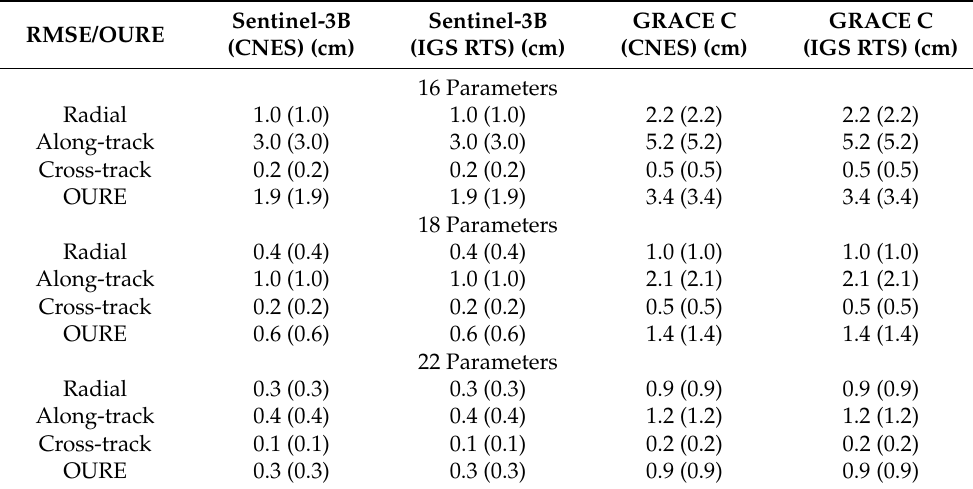
Table 10. Averaged RMS and OURE of the ephemeris fitting errors for the predicted orbits of 5–15 min. The results without outlier exclusions are given in parentheses.